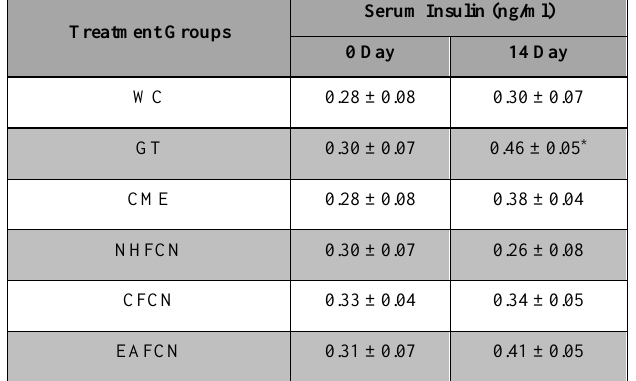
Table 1. Effects of Cocos Nucifera extracts on fasting serum insulin level of type II diabetic rats. Treatment